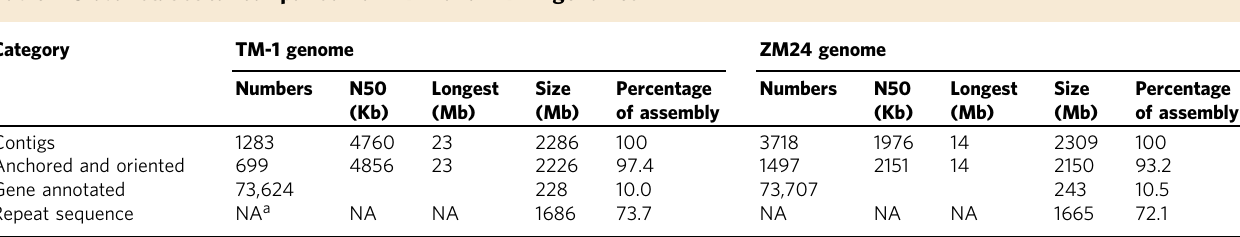
Table 1 Global statistical comparison of TM-1 and ZM24 genomes Category TM-1